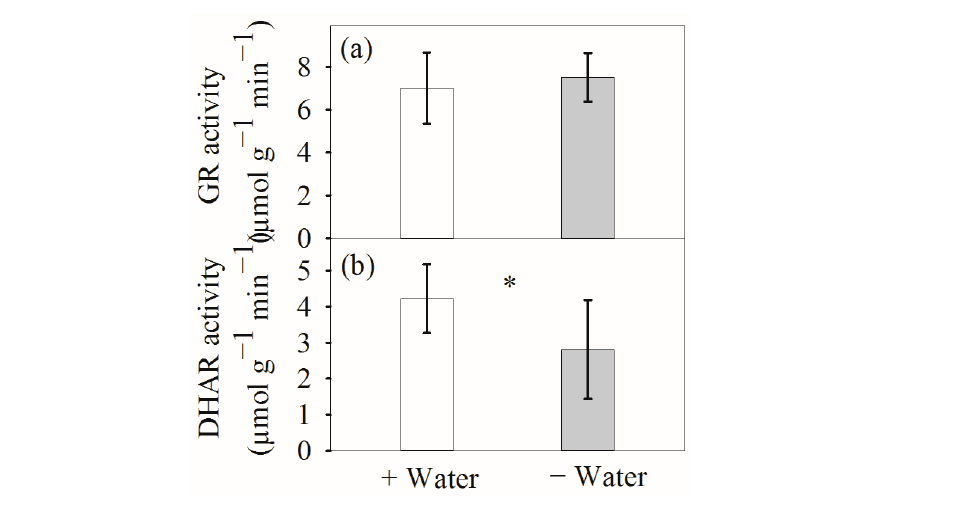
Figure 7. Activities of glutathione reductase (GR) ( a ) and dehydroascorbate reductase (DHAR) ( b ) in leaves of Alnus glutinosa grown under sufficient (+ water, blank bars) and limited water conditions ( − water, grey bars). Data shown represent mean ± standard deviation ( n = 5) on a dry weight basis. Asterisk (*) indicates significant differences between trees with sufficient and limited water supply at p < 0.05.